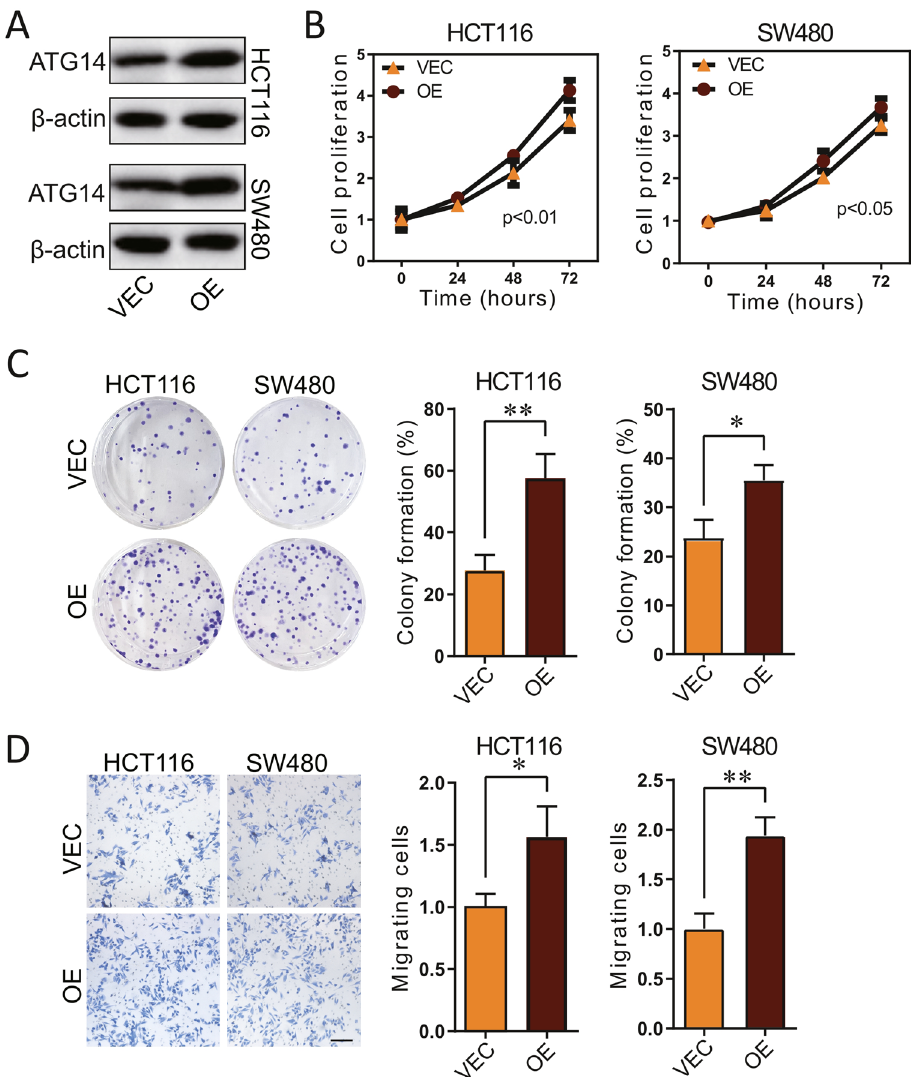
Figure 10. Validation of the function of ATG14 in CRC cell lines. ( A ) Western blotting of ATG14 and beta- actin in vector or ATG14 overexpressed HCT116 and SW480 cells; ( B ) Cell proliferation of vector or ATG14 overexpressed HCT116 and SW480. ( C ) Colony formation of vector or ATG14 overexpressed HCT116 and SW480. ( D ) Cell migration of vector or ATG14 overexpressed HCT116 and SW480, determined by Transwell assay, scale bar, 100 μm. *p < 0.05; **p <